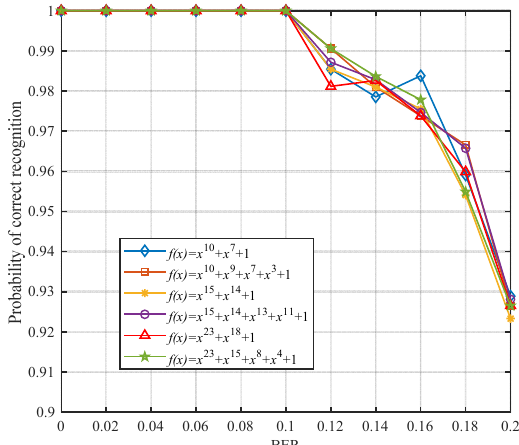
Figure 13. Influence of scrambling code generator polynomial on the recognition rate.